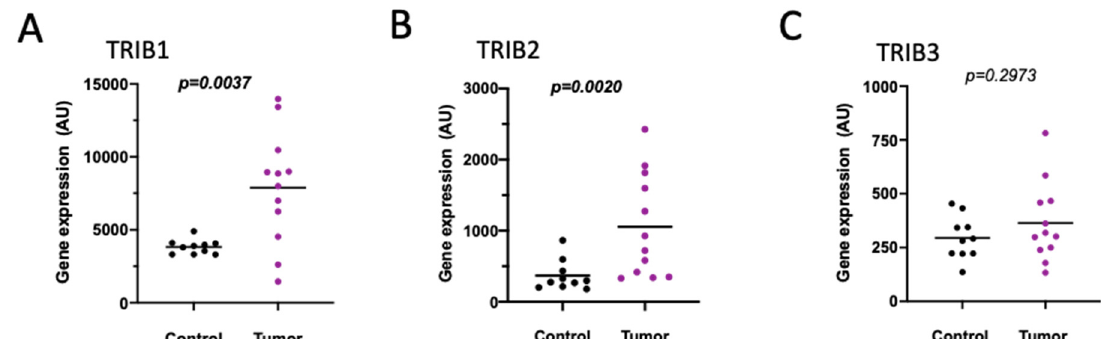
Figure 2. TRIB1 , TRIB2 , and TRIB3 gene expression in normal-appearing colon tissues adjacent to colorectal tumors compared to healthy control mucosa. ( A – C ): Normal-appearing colonic mucosa of early onset colorectal cancer (CRC) Chinese patients without a prior family history of CRC (Tumor, n = 10), whose tumors were classified as microsatellite-stable, age equal or lower than 50, compared to healthy control mucosa, i.e., normal colon from healthy controls (Control, n = 12) (GDS2609). TRIB1 (( A )—202241_at), TRIB2 (( B )—202478_at), and TRIB3 (( C )—218145_at) gene expression is represented as arbitrary units (AU). Unpaired two-tailed t test ( C ), t test with Welch’s correction ( A ), or Mann–Whitney U test ( B ) was performed, and the p value is represented for each graph. The horizontal bars represent the mean of the values in each group.